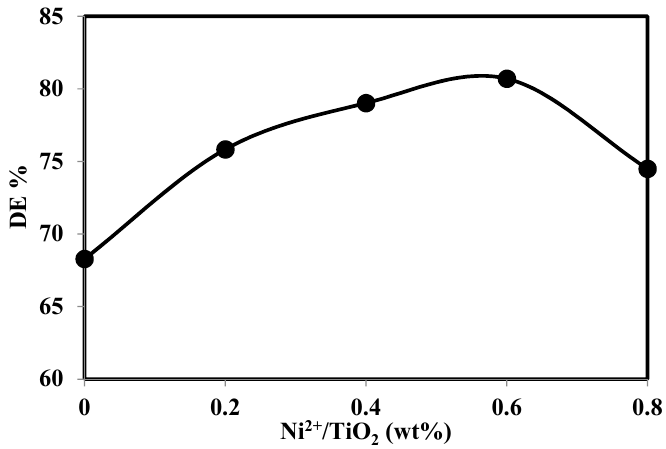
Figure 12. DE% of chloroxylenol using different wt % of Ni 2+ /TiO 2 .